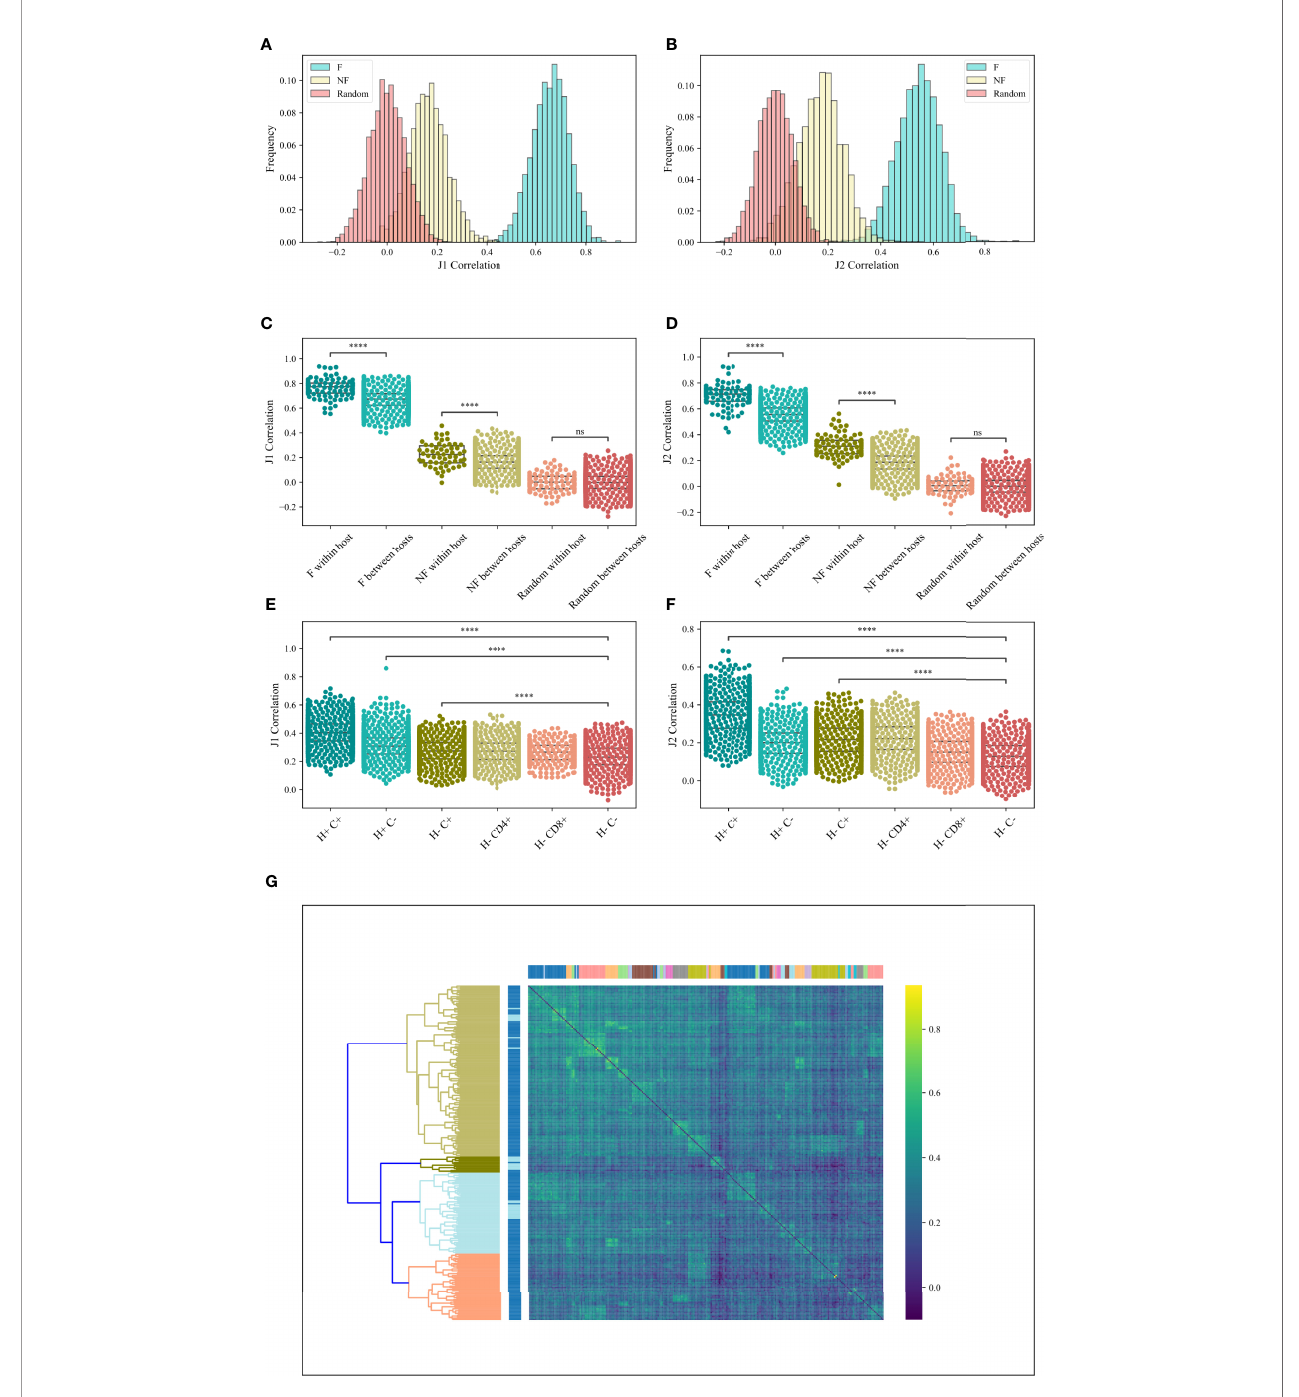
FIGURE 4 | M ( V b , J b ) correlation. (A, B) The correlations histogram of the M ( V b , J b ) values for the J b 1 family gene (A) and the J b 2 family gene (B) in the RH dataset. The blue histogram represents the F clones, the beige histogram is the NF clones and the pink histogram represents the null model. (C, D) Correlations of M ( V b , J b ) values for the J b 1 family gene (C) and the J b 2 family gene (D) in the RH dataset within host and between hosts for F, NF and random clones. Star symbols follow the previous plot. (E, F) Correlations of M ( V b , J b ) values for the J b 1 family gene (E) and the J b 2 family gene (F) in the MM dataset, where H+ represents within host, H- represents between hosts, C+ represents within compartment, C- represents between compartments. (G) Heatmap of the correlations of M ( V b , J b ) values for the M J b 1 family gene of the F clones in the MM data set. At the top we colored according to a patient, while on the left we colored according to the compartments (CD4 or